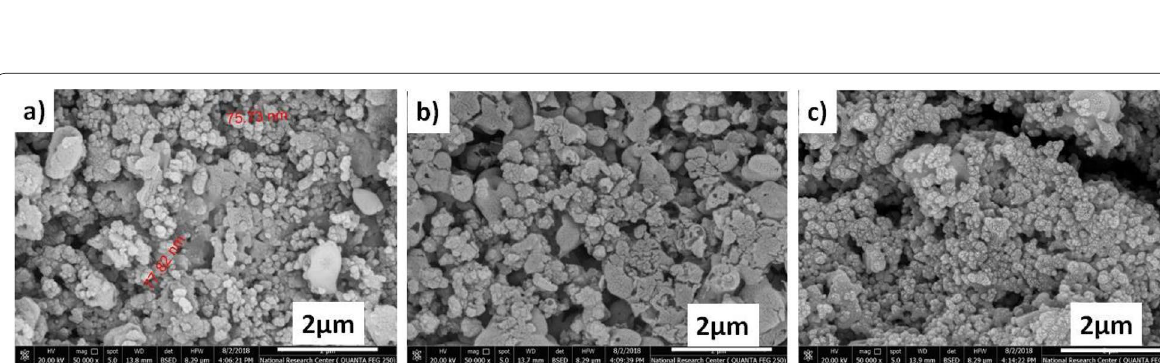
Fig. 7 SEM images of the ceramic nanocomposite. a C1, b C2, and c C3